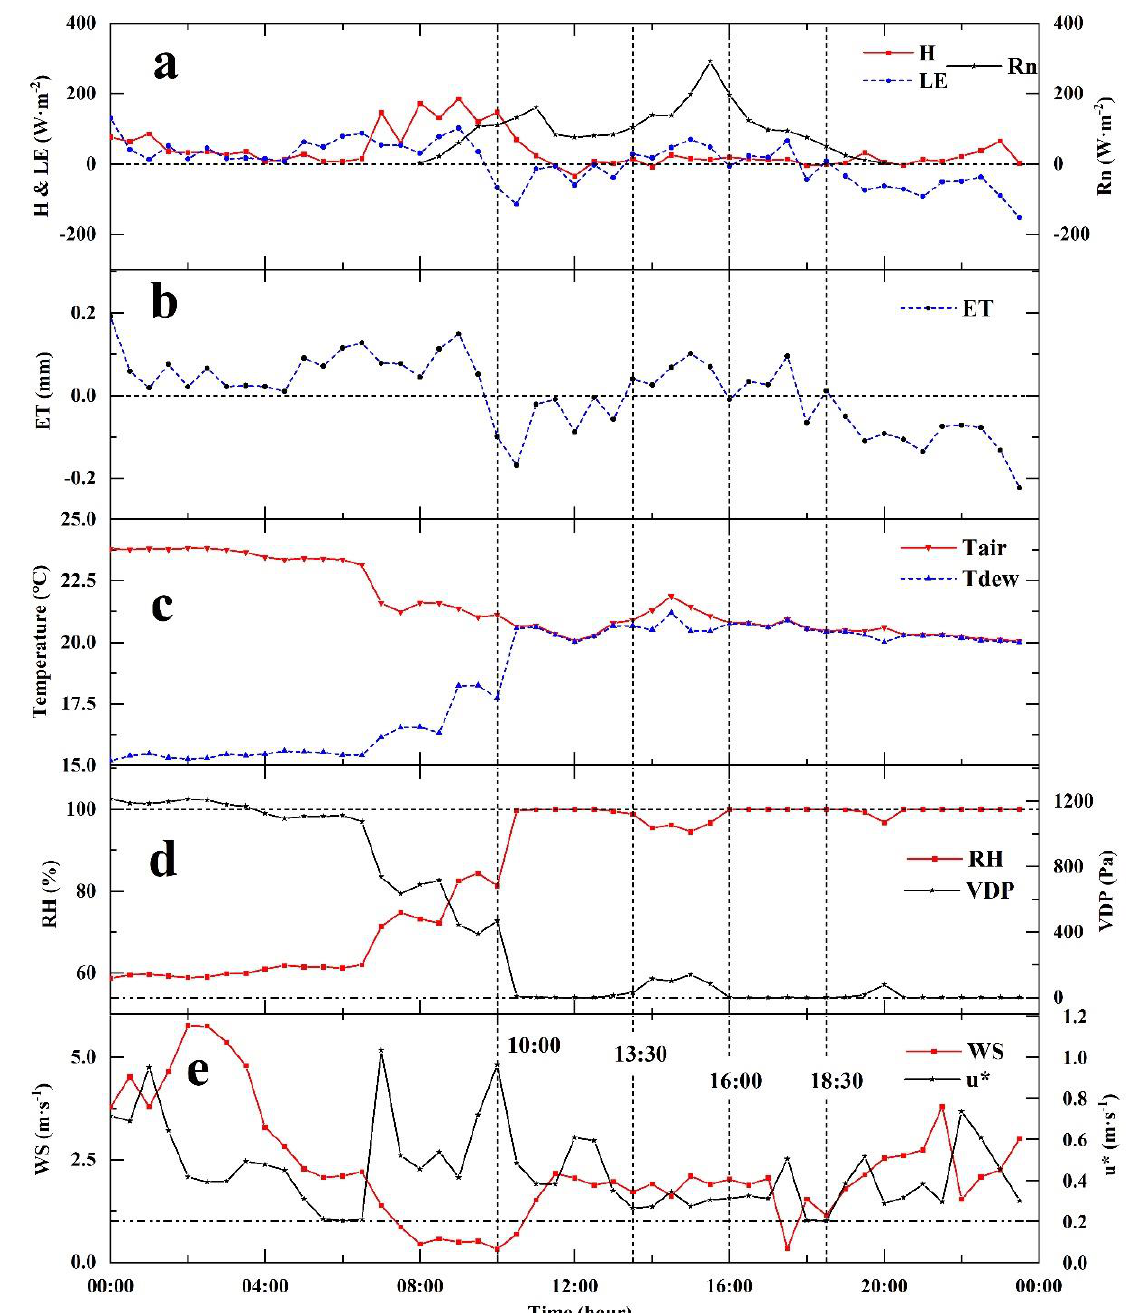
Figure 13. Intraday changes of FEs and environmental factors during fog on 3 June 2017. ( a,b ) Intraday changes of FEs during fog day. ( c − e ) Intraday changes of environmental factors during fog day: ( a ) H represents sensible heat flux, LE represents latent heat flux, Rn represents net radiation, ( b ) ET represents evapotranspiration, ( c ) Tair represents air temperature, Tdew represents dew point temperature, ( d ) RH represents relative humidity, VPD represents vapor pressure deficit, ( e ) WS represents wind speed, and u* represents friction wind speed.